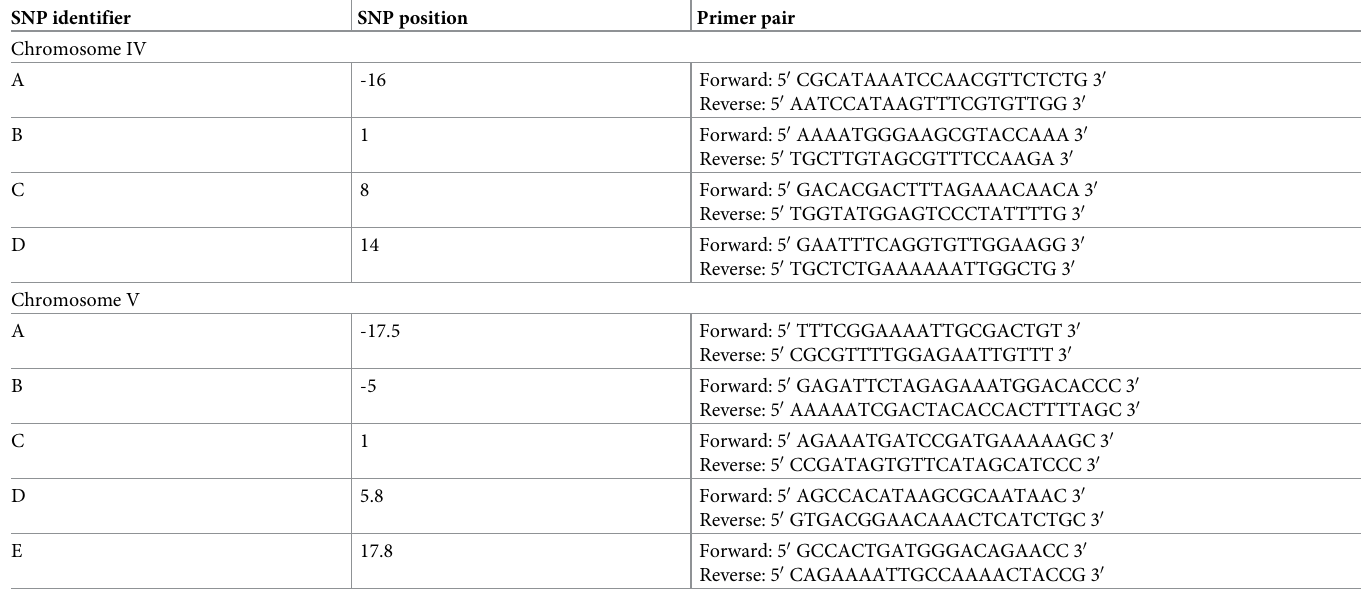
Table 3. SNP positions and